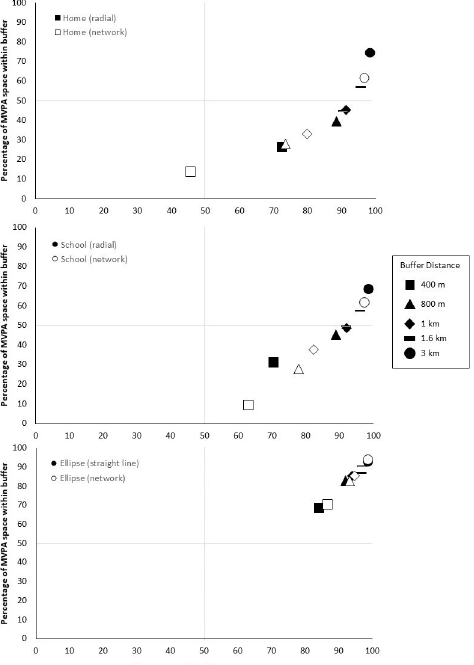
Fig 2. Comparison of buffers in capturing MVPA space and unused space by home, school and ellipse.